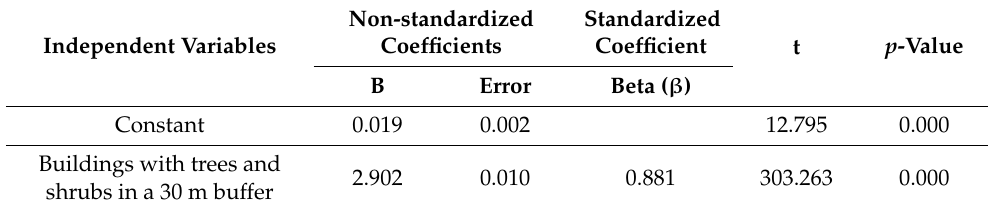
Table 1. Summary of the multiple regression significance of defensible space explanatory variables.